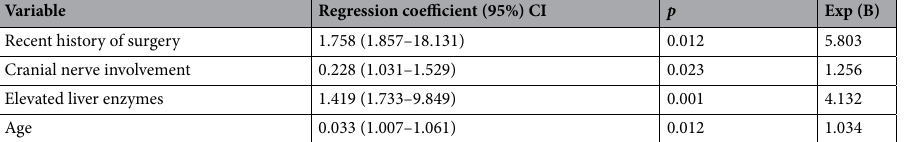
Table 3. Possible independent risk factors for the severity of GBS in multivariate logistic regression. GBS: Guillain-Barré syndrome; CI: Confidence interval.